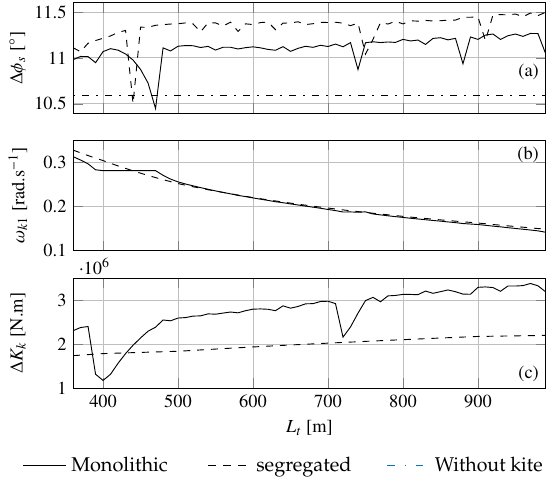
Figure 14. ( a ) Amplitude of the ship roll motion, ( b ) first kite harmonic frequency and ( c ) amplitude of the kite moment of excitation for different tether lengths from 360 m to 990 m by step length of 10 m with a beam regular wave of 2.5 m high at a frequency of ω w = 0.4 rad.s − 1 .